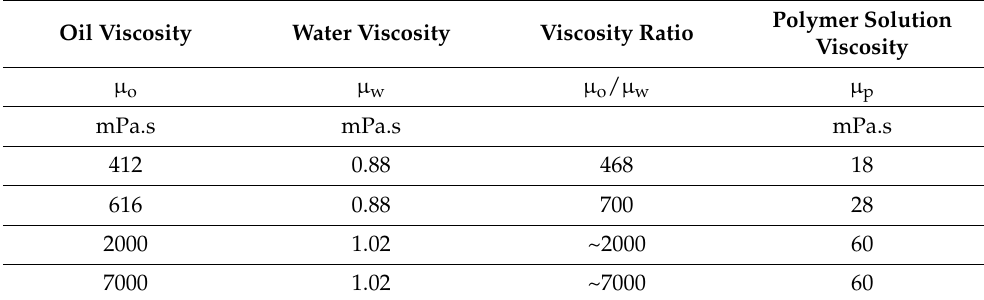
Table 1. Oil, water, and polymer solution